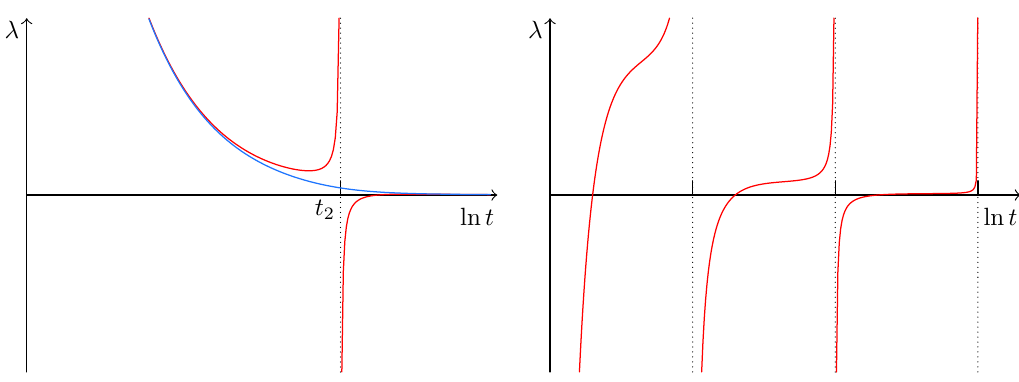
Figure 3 . Solutions for the scalar quartic (cid:21) in the model (4.1). The IR pole of g 2 lies at the coordinate origin, i.e. t 2 = 0. The positions of other poles of (cid:21) are depicted by the vertical dotted lines. Left: real (cid:14) . The (cid:12)rst family of solutions is shown in blue, the second one in red. Right: imaginary (cid:14) . These solutions can exhibit walking